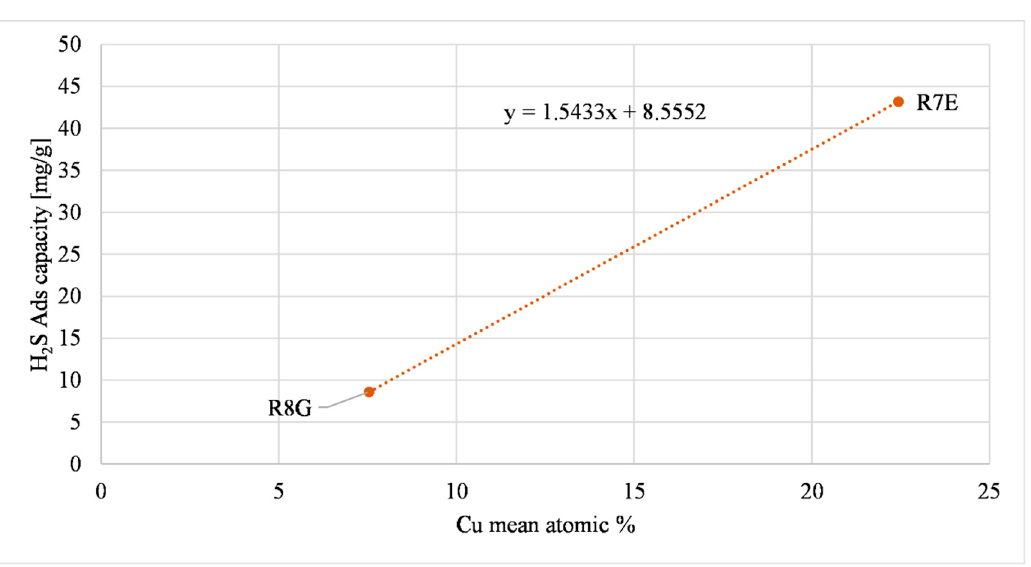
Figure 11. Copper oxide effect on H 2 S adsorption (AC as-received).